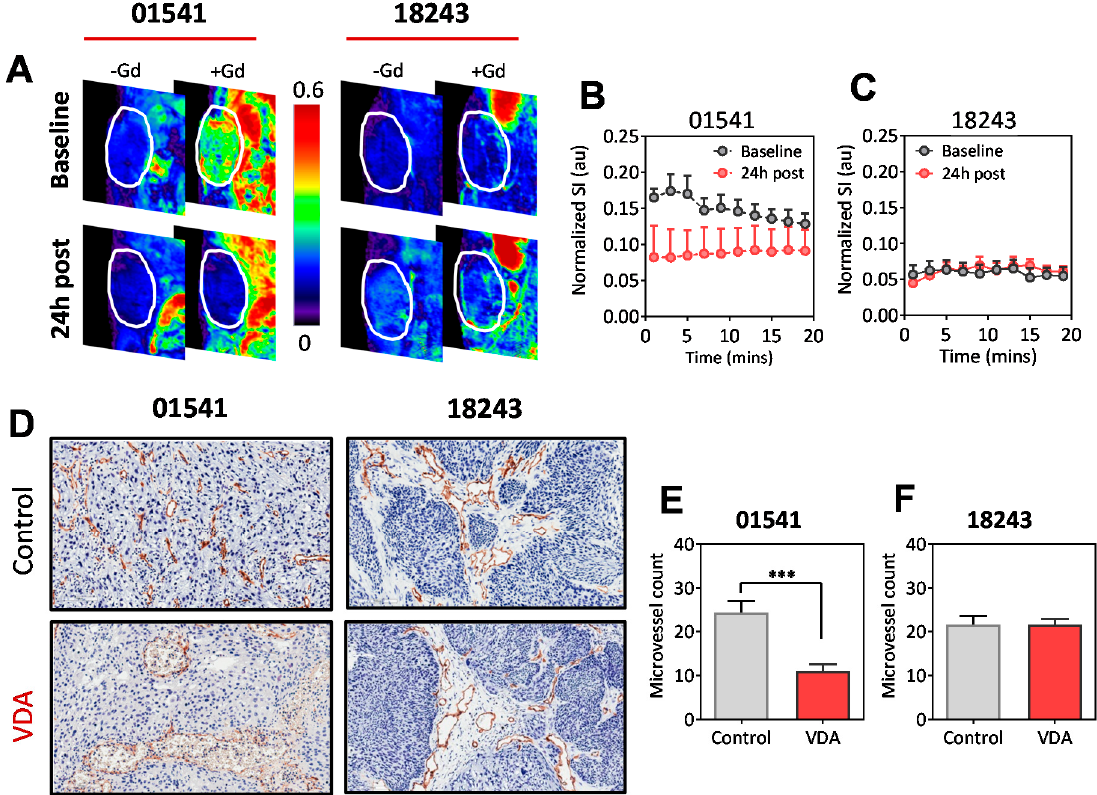
Figure 6. Functional imaging of heterogeneity in susceptibility to vascular-targeted therapy in vivo. ( A ) Normalized T1-weighted images of the p16 − PDX 01541 and p16 + PDX 18243 at baseline and 24 h post treatment with the microtubule targeted VDA, EPC2407. Pseudo-colorized images of the PDX before and after contrast (Gd) are shown to visualize contrast enhancement within the tumor. Dynamic changes in T1-weighted signal intensity values (as a measure of contrast enhancement) of the p16 − PDX (01541; B ) and p16 + PDX (18243; C ) at baseline (gray circles) and 24 h post EPC2407 treatment (red circles). ( D ) CD31-immunostained tumor sections confirmed the di ff erential vascular response between the PDX models with marked vascular damage seen in the 01541 model (bottom; VDA). In comparison, EPC-treated tumors in the 18243 model appeared similar to controls with intact CD31 + vessels visible in the tumor stroma. A significant reduction in microvessel count was seen in the 01541 PDX ( E ) following EPC treatment (red bar; VDA). EPC-treated tumors showed comparable vessel counts to control tumors in the 18243 PDX ( F ). *** p <